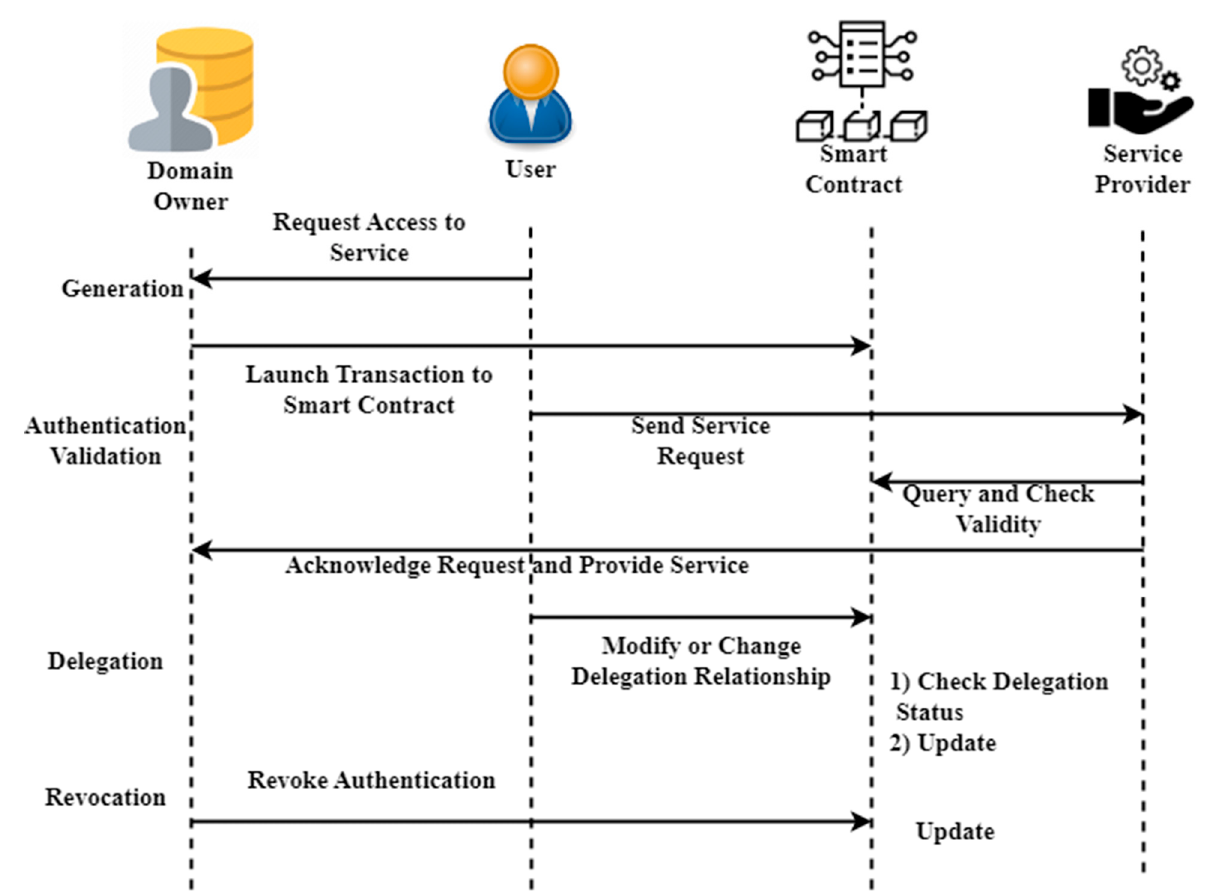
Figure 3. Flowchart of access right authorization.